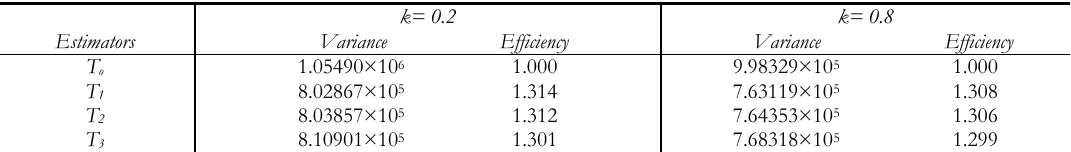
Variances of the proposed